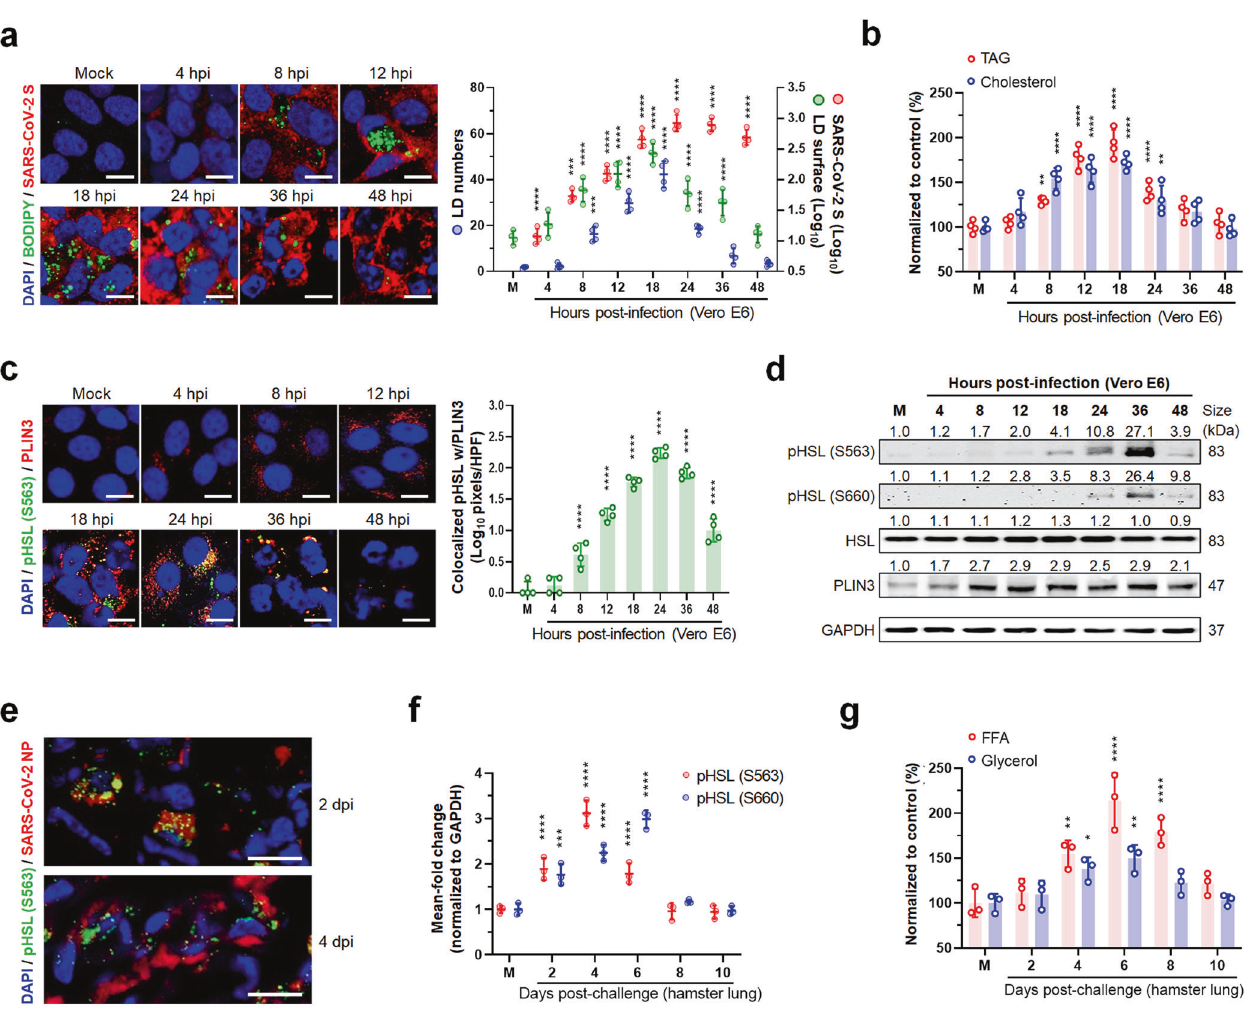
Fig. 1 In vitro and in vivo activation of lipid droplet (LD)-associated hormone-sensitive lipase (HSL) during SARS-CoV-2 replication. a Representative images (left) and quanti fi cation (right) of sequential changes of BODIPY-stained intracellular LDs (green) and SARS-CoV-2 S protein (red) in Vero E6 cells infected with SARS-CoV-2 KCDC03 strain at an MOI of 0.1 FFU. b Dynamics of intracellular triacylglycerol (TAG) and cholesterol in the cells infected with SARS-CoV-2 at an MOI of 0.1 FFU. c Representative images (left) and quanti fi cation (right) of phosphorylated HSL (pHSL, green) colocalized with the LD surface marker perilipin-3 (PLIN3) (red) of cells infected with SARS-CoV-2 at an MOI of 0.1 FFU. d Representative western blot. Sequential expression levels of pHSLs (S563 and S660) and PLIN3 in SARS-CoV-2-infected cells at an MOI of 0.1 FFU. e Representative images of pHSL (S563, green) and SARS-CoV-2 NP antigen (red) levels in the alveolar epithelial cells of lung tissues sampled at 2 and 4 dpi from Syrian hamsters challenged with 10 5 TCID 50 of SARS-CoV-2 KCDC03 strain. f , g Dynamics of pHSLs (S563 and S660) and intracellular free fatty acids (FFAs) and glycerol in lung tissues obtained sequentially from Syrian hamsters challenged with 10 5 TCID 50 of SARS-CoV-2. All data in the graphs are presented as arithmetic means ± SD from four independent experiments with three experimental animals. One-way analysis of variance was carried out with Tukey ’ s correction for multiple comparisons. * P < 0.05, ** P < 0.01, *** P < 0.001, **** P < 0.0001. Scale bars = 50